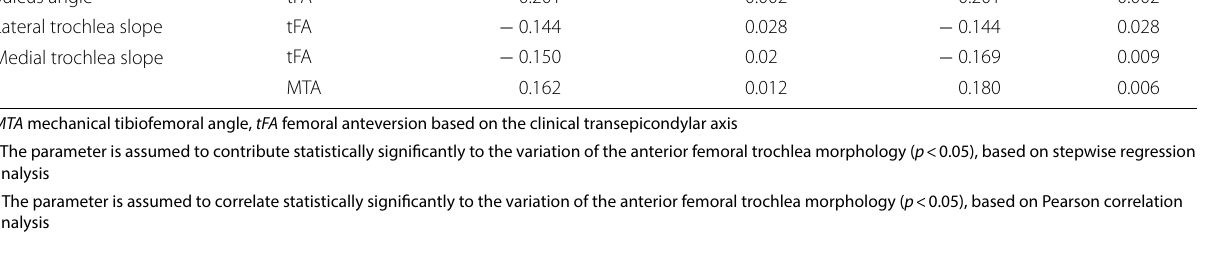
Table 4 T -test analysis of morphology of the femoral trochlea with pFA